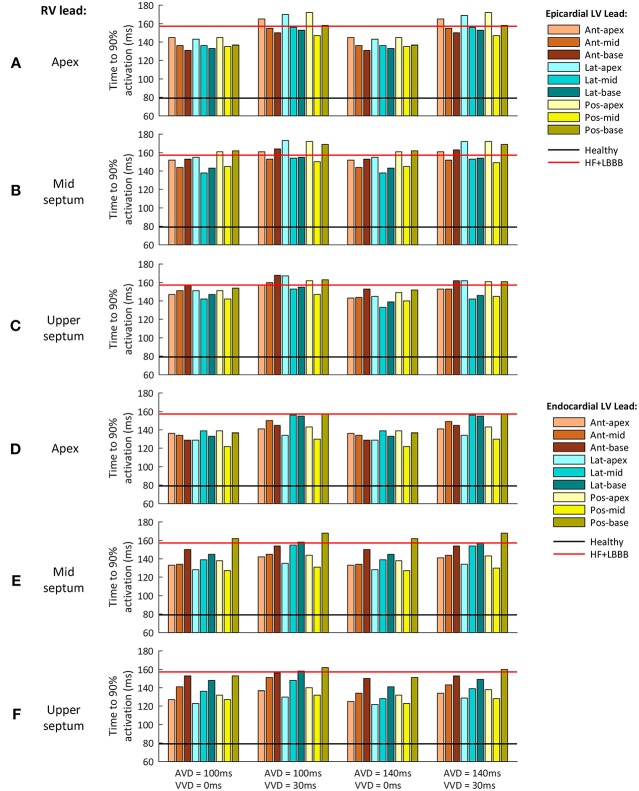
Time to 90% of ventricular activation for the different CRT configuration delays assessed. (A–C) Epicardial LV lead stimulation for the three RV lead location tested: (A) RV apex, (B) RV mid septum and (C) RV upper septum. (D–F) Endocardial LV lead stimulation for the three RV lead location tested: (D) RV apex, (E) RV mid septum and (F) RV upper septum. The three LV regions (anterior, lateral and posterior walls) are shown in different color brightness (red, blue and yellow). The values for healthy and HF + LBBB configurations are depicted in black and red lines respectively.